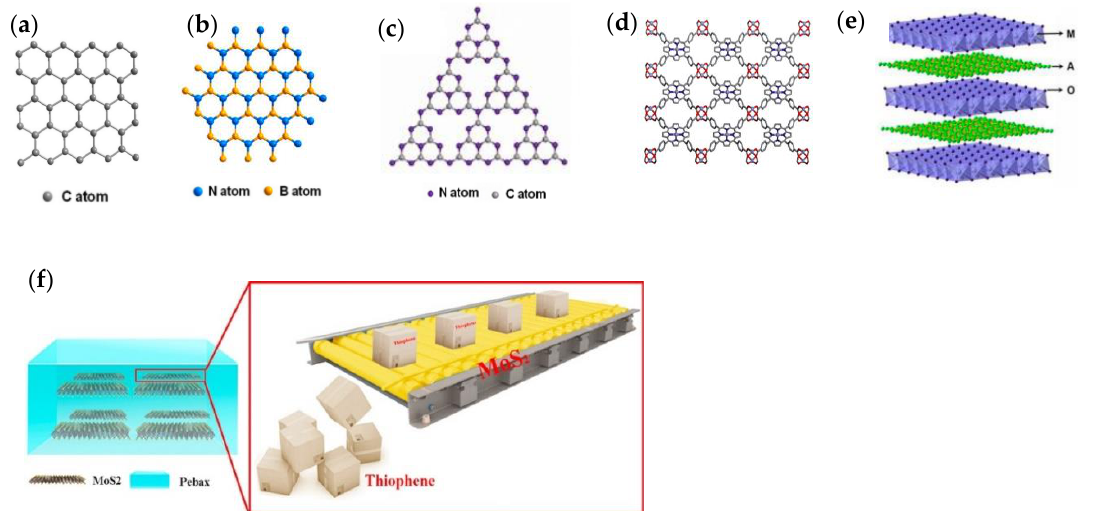
Figure 4. Structures of ( a ) graphene, and ( b ) hexagonal boron nitride, ( c ) s-triazine structure models of g-C 3 N 4 , ( d ) MOF nanosheet and ( e ) layered double hydroxides. Reproduced with permission from [71], published by American Chemical Society, 2017. ( f ) MoS 2 in Pebax as transport facilitator for thiophene. Reproduced with permission from [52], published by Elsevier, 2018.